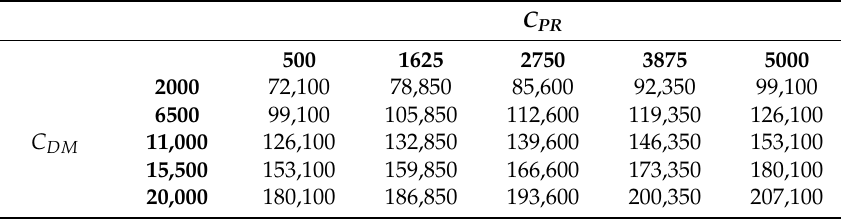
Table 4. Cost ( € ) analysis as a function of C DM and C PR —Setup